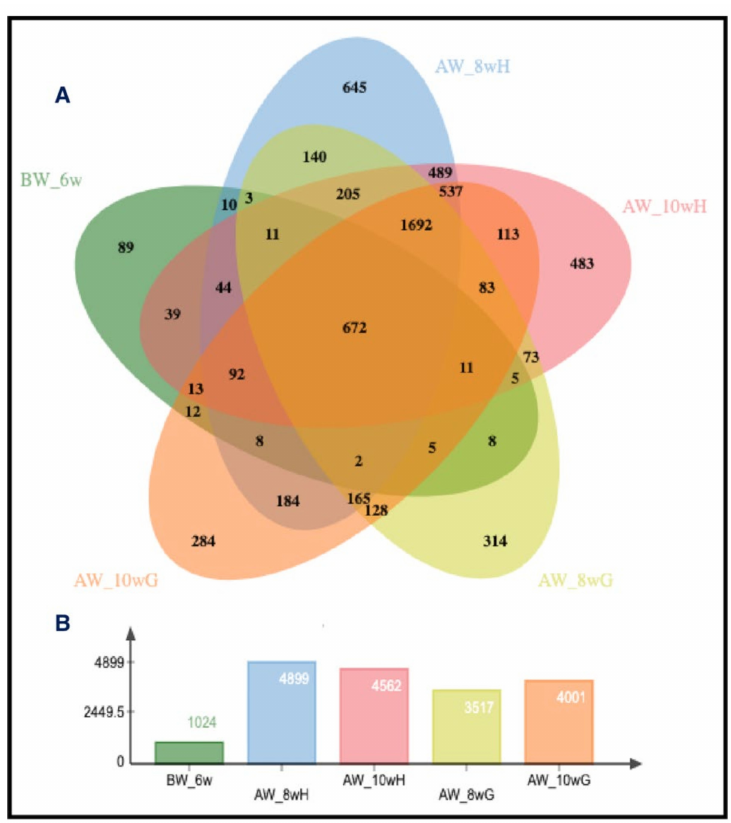
Figure 3. ( A ) A five-way jvenn Diagram (adapted from [19]) illustrates the number of DEGs for each group comparison, as well as the unique and overlapping DEGs among all of the groups. There are 672 DEGs common in all five groups. Moreover, the diagram also shows the number of unique DEGs in each of the groups. In the BW6w group, there are only 89 unique DEGs, compared to 648 DEGs in AW 8wH, 483 DEGs in AW 10wH, 314 DEGs in AW 8wG, and 284 DEGs in AW 10wG. ( B ) The number of DEG represents each group compared to the two-week-old MRO